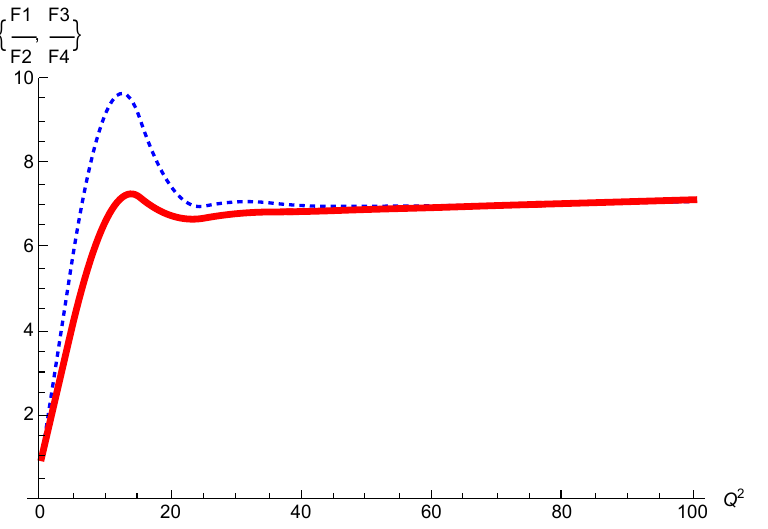
Figure 14. The ratios of the form factors for the states with n = 1 and n = 2. The dotted curve is the ratio for states Nos. 1 and 2 from Table 1, κ = 0. The solid curve corresponds to the ratio for states Nos. 3 and 4, κ = 2. (Adapted from [1]).